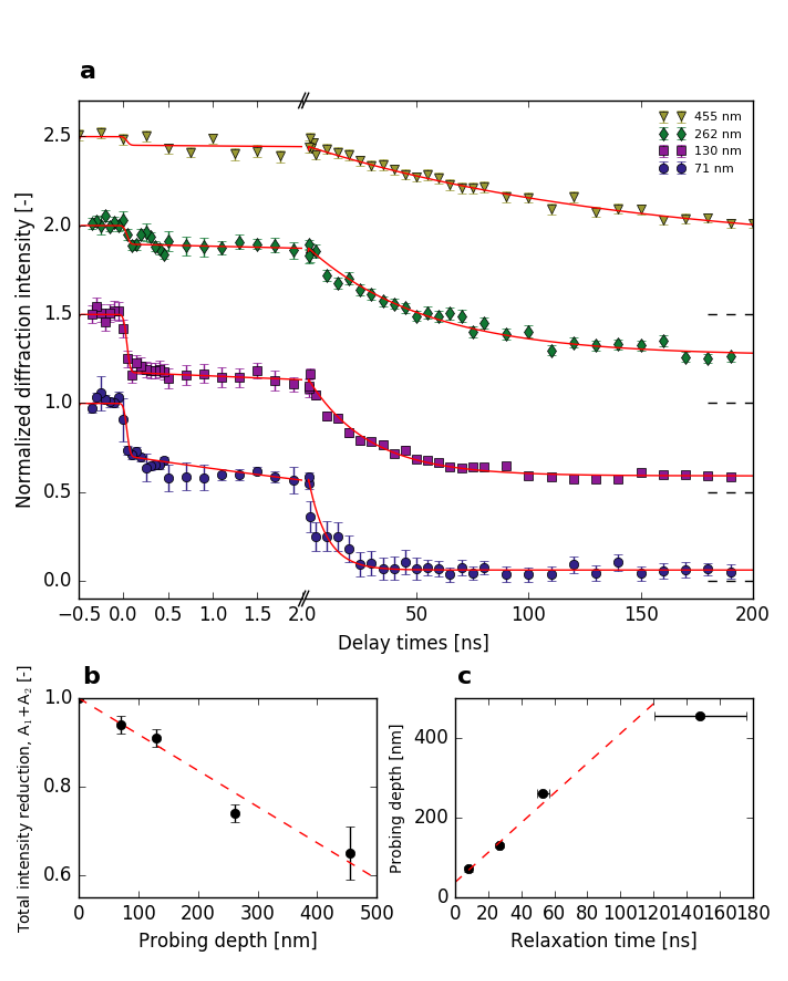
Figure 3. ( a ) Intensity of the superlattice reflection ( − 0.9 0.0 − 2.1) as a function of pump-probe delay for X-ray penetration depths of (cid:72) , (cid:7) , (cid:4) , • = 71, 130, 262, 455 nm at a fluence of 3.5 mJ/cm 2 . Traces have been vertically offset for clarity. Red lines show the result of fitting the model described in the text to the data. ( b ) Total intensity reduction as a function of probing depth with a linear fit. ( c ) Probing depth as a function of relaxation time with a linear fit whose slope is 3.7